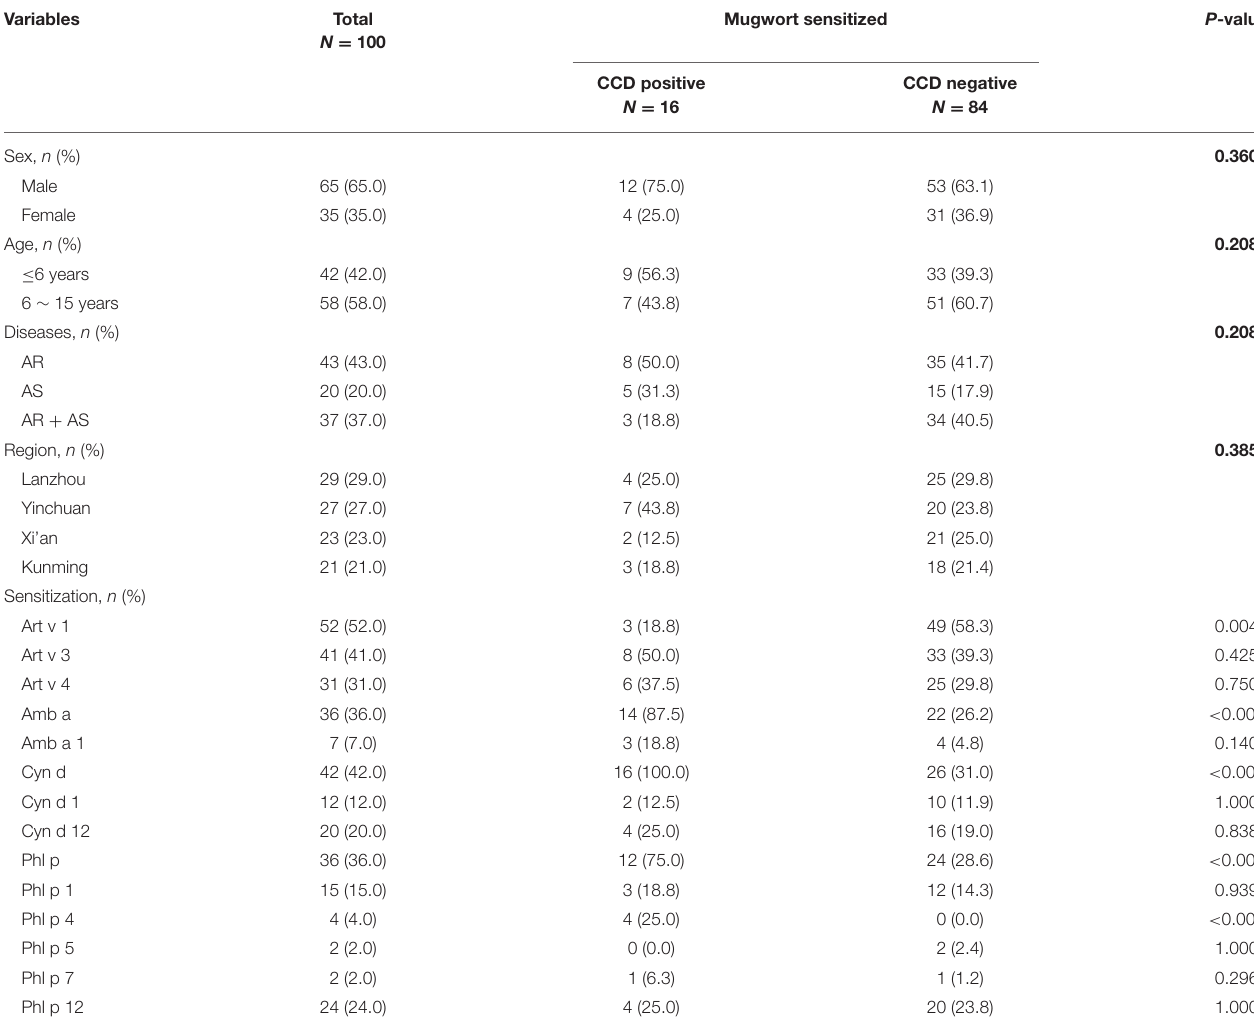
TABLE 1 | The characteristics of patients with mugwort sensitization.